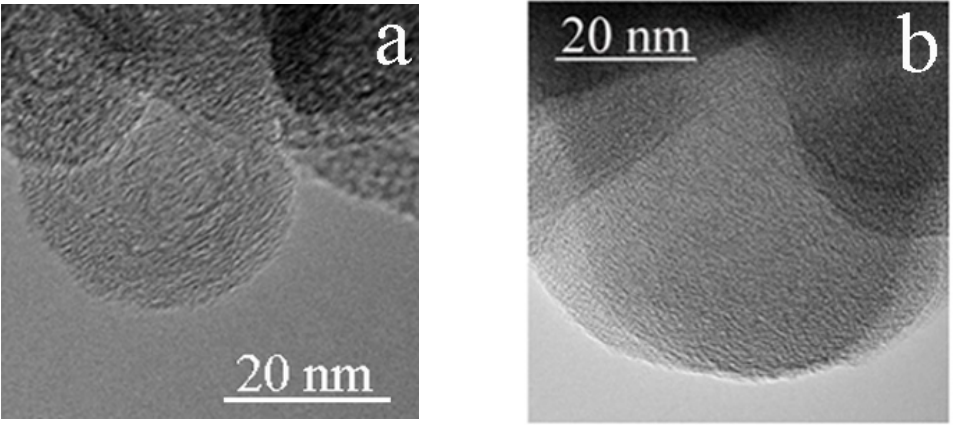
Figure 4. TEM image of the g -C 3 N 4 specimen after shear deformation at 53–57 GPa. Figure 5 shows the TEM images of the specimen quenched from 79 GPa after shear deformation at 70 GPa.